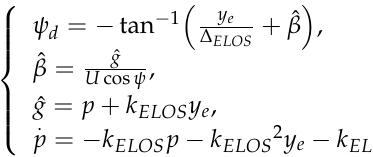
Figure 4. Comparison of lateral position with different guidance laws at 0.1